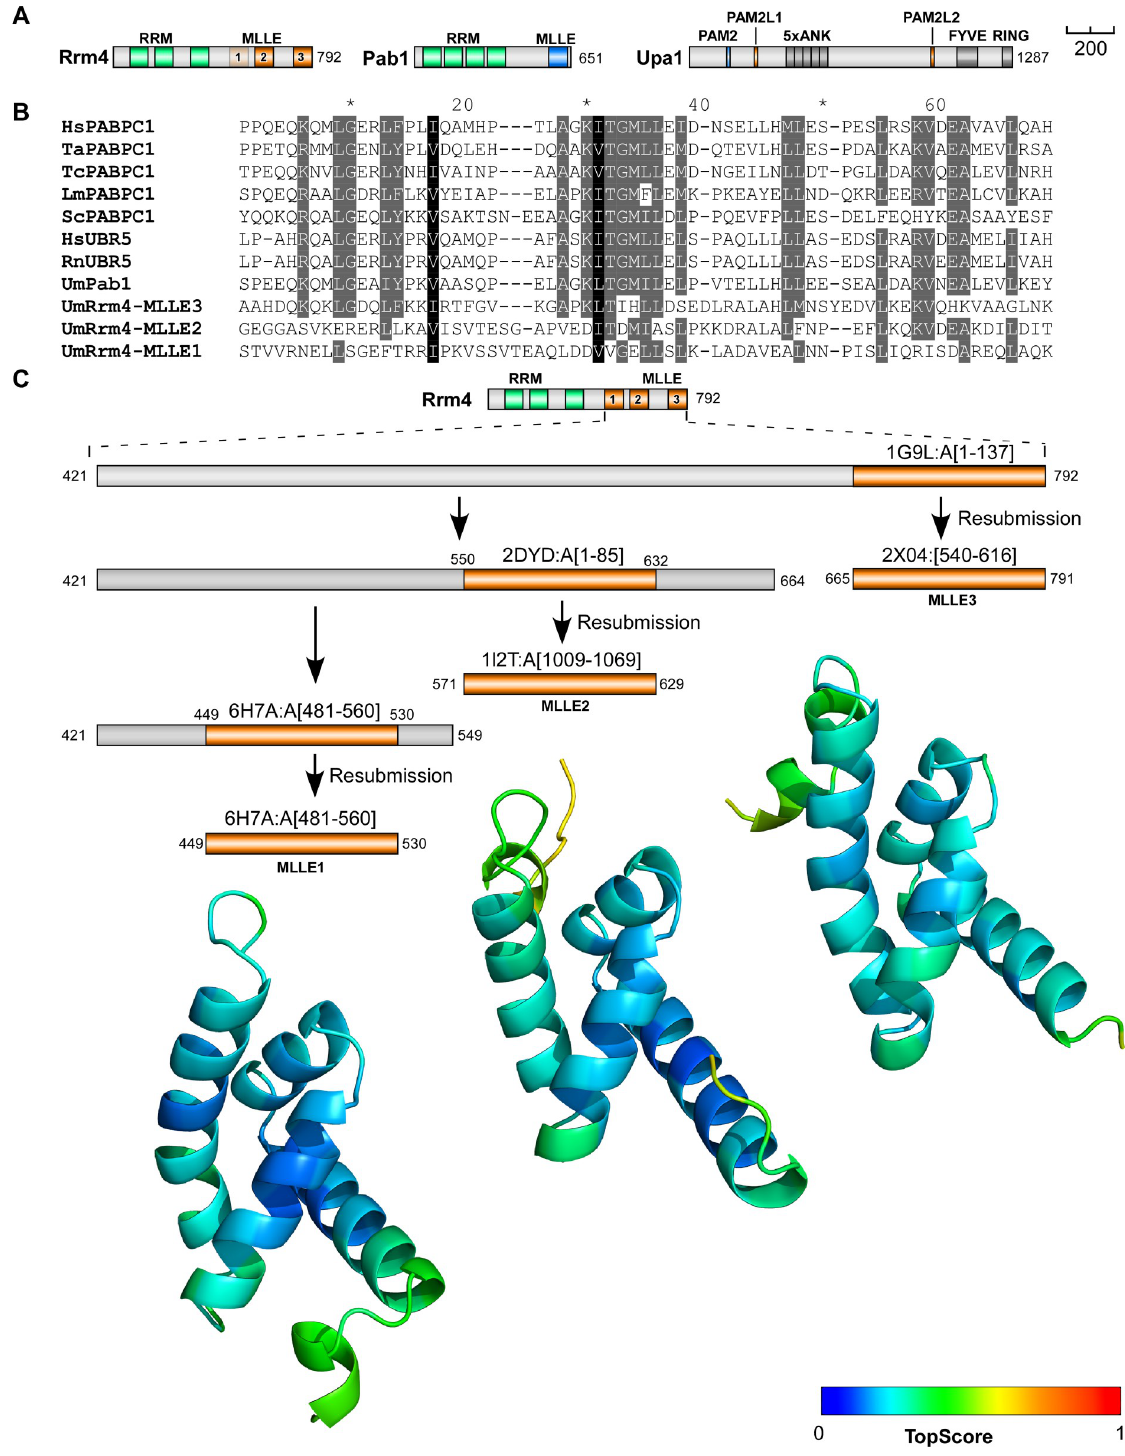
Fig 1. The C-terminal half of Rrm4 contains three MLLE domains. ( A ) Schematic representation of protein variants drawn to scale (bar, 200 amino acids, number of amino acids indicated next to protein bars) using the following colouring: dark green, RNA recognition motif (RRM); orange, MLLE Rrm4 domains; dark blue, MLLE Pab1 ; light blue PAM2; light orange PAM2L sequence (PL1–2) Ankyrin repeats (5xANK), FYVE domain, and RING domain of Upa1 are given in dark grey. ( B ) Sequence alignment of previously determined MLLE domains showing the degree of similarity to the three Rrm4-MLLE domains and the positions (Hs— Homo sapiens , Ta— Triticum aestivum , La— Leishmania major , Sc— Saccharomyces cerevisiae , Tc— Trypanosoma cruzi , Rn— Rattus norvegicus , Um— Ustilago maydis , PABPC1, Pab1 –poly [A]-binding protein, UBR5—E3 ubiquitin-protein ligase). Accession number and sequence coverage are listed in S1 Table.